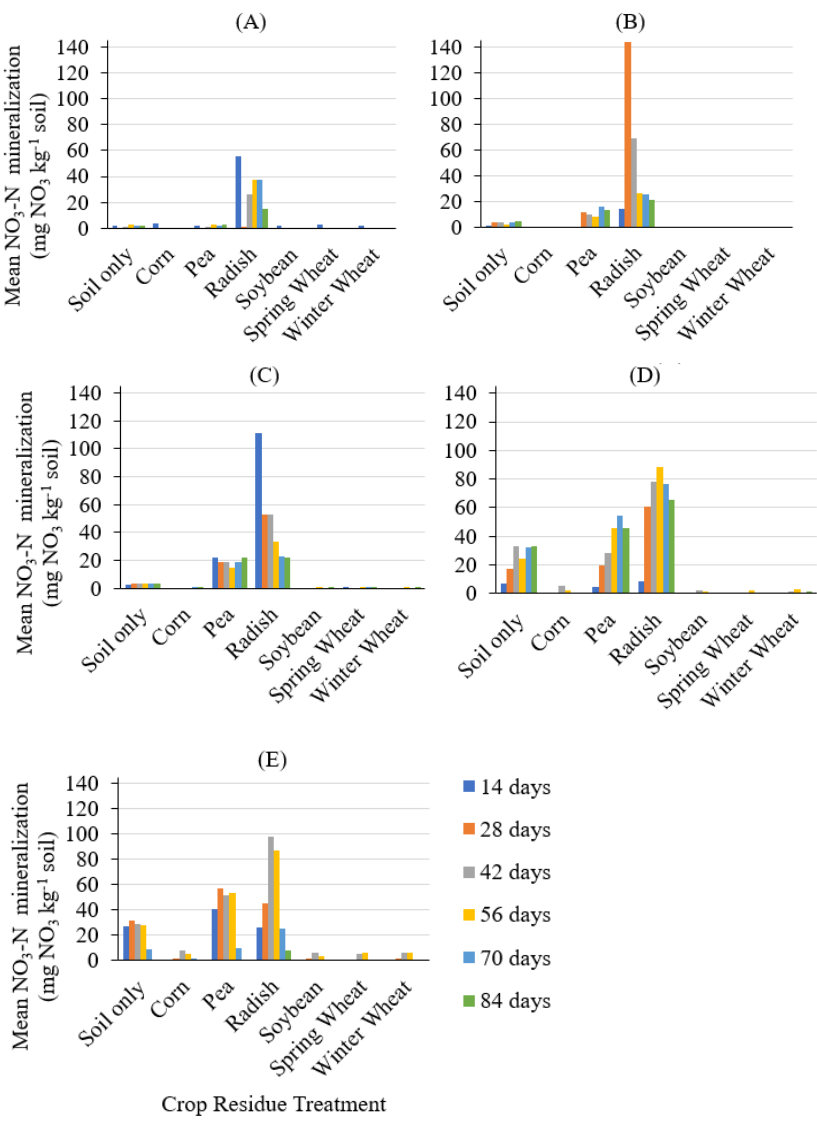
Figure 3. First incubation ( A ), second incubation ( B ), third incubation ( C ), fourth incubation ( D ), and fifth incubation ( E ) cycle mean soil NO 3 -N mineralization patterns for control, corn, pea, radish, soybean, spring wheat, and winter wheat crop residue treatments by incubation period.